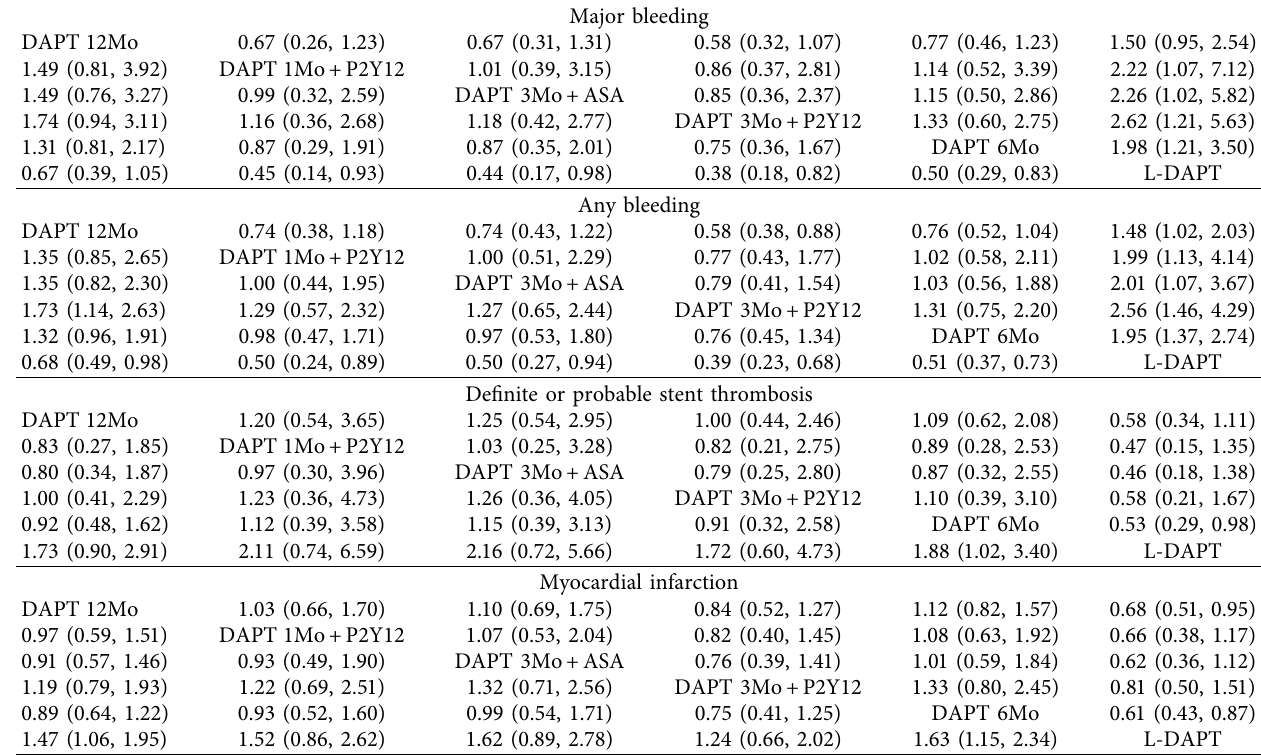
Table 1: Pooled estimates of the network meta-analysis of ischemic and hemorrhagic endpoints. Major